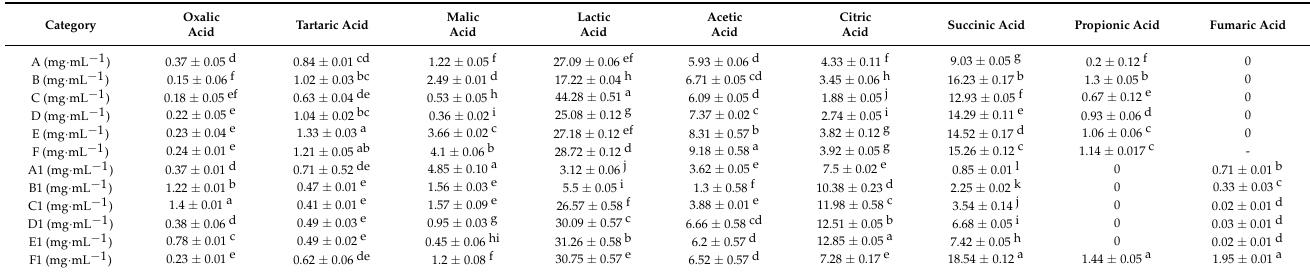
Values are expressed as the mean ± standard error ( n = 3); different letters (a–l) in the same column indicate significant differences ( p < 0.05). (A–F) represent samples during traditional tomato sour soup (CTN) fermentation. (A1–F1) represent the samples during the fermentation process of the enhanced fermentation tomato sour soup (TN). The organic acids that contribute greatly to the TN group are lactic acid (31.26 mg · mL − 1